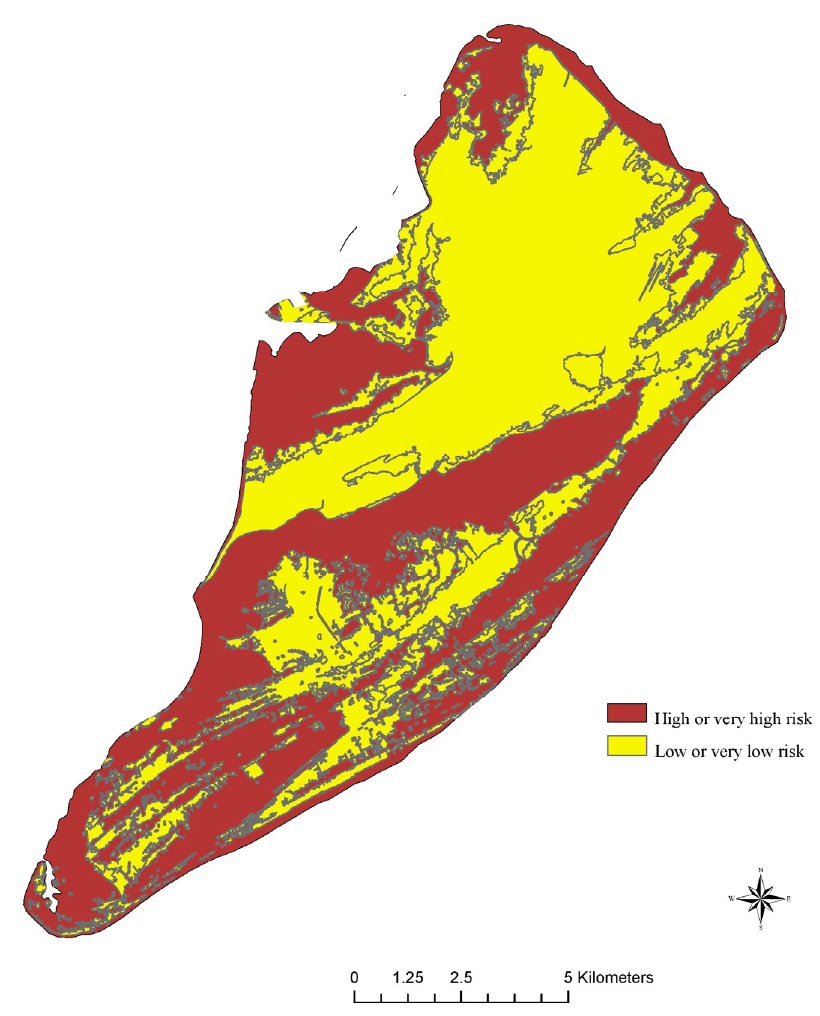
Figure 3. Flood risk